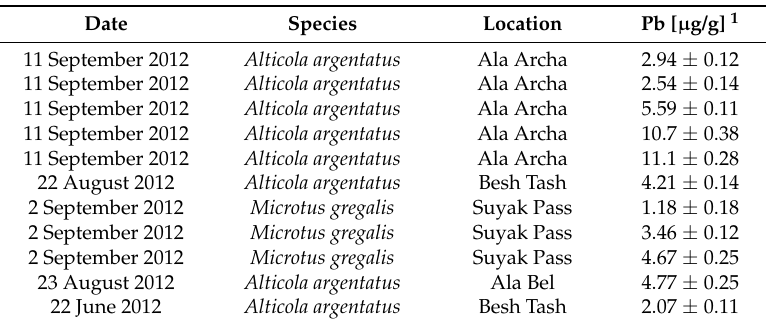
Table 1. Pb contents in two vole species from Tien-Shan obtained by using electro-thermal atomic absorption spectroscopy.